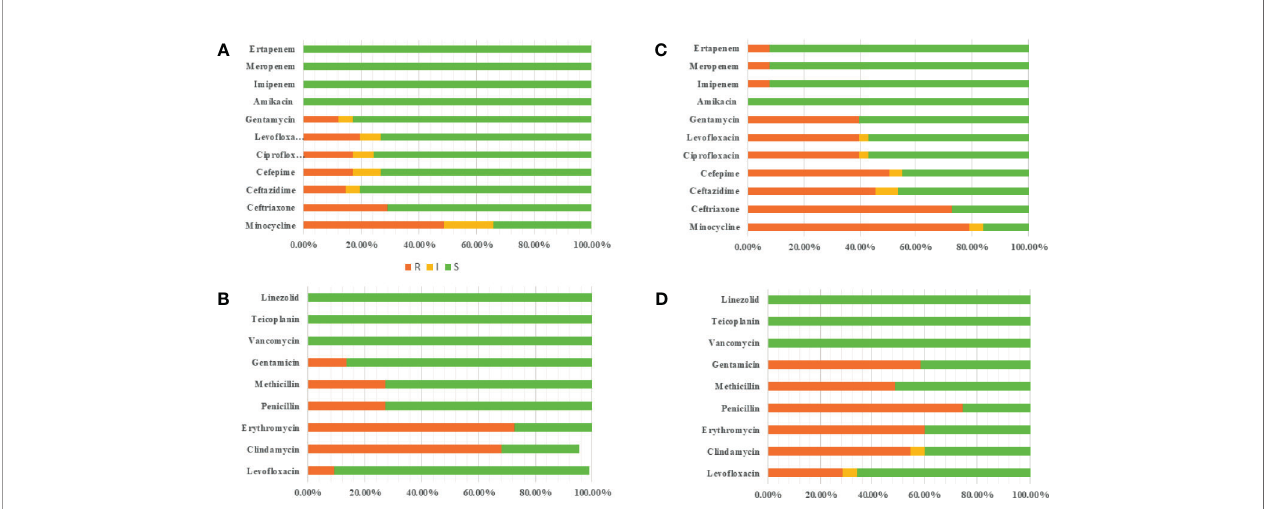
FIGURE 4 | Antimicrobial susceptibility of pathogen in EOS and LOS. (A) Antimicrobial susceptibility of Gram-negative bacilli in EOS. (B) Antimicrobial susceptibility of Gram-positive bacilli in EOS. (C) Antimicrobial susceptibility of Gram-negative bacilli in LOS (D) Antimicrobial susceptibility of Gram-positive bacilli in